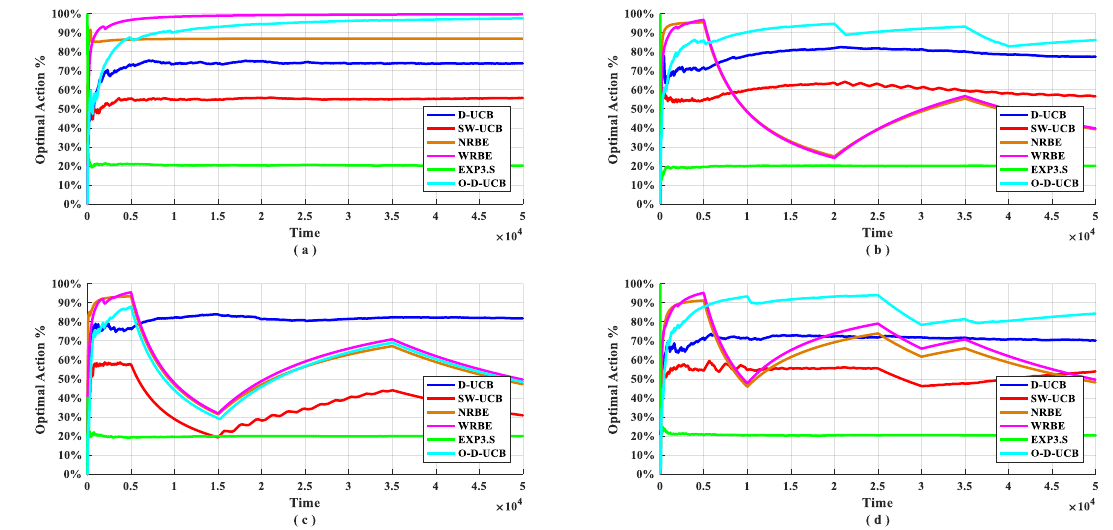
Figure 10. The optimal arm utilization rate of each policy under different datasets. ( a ) describes dataset a. ( b ) describes dataset b. ( c ) describes dataset c. ( d ) describes dataset